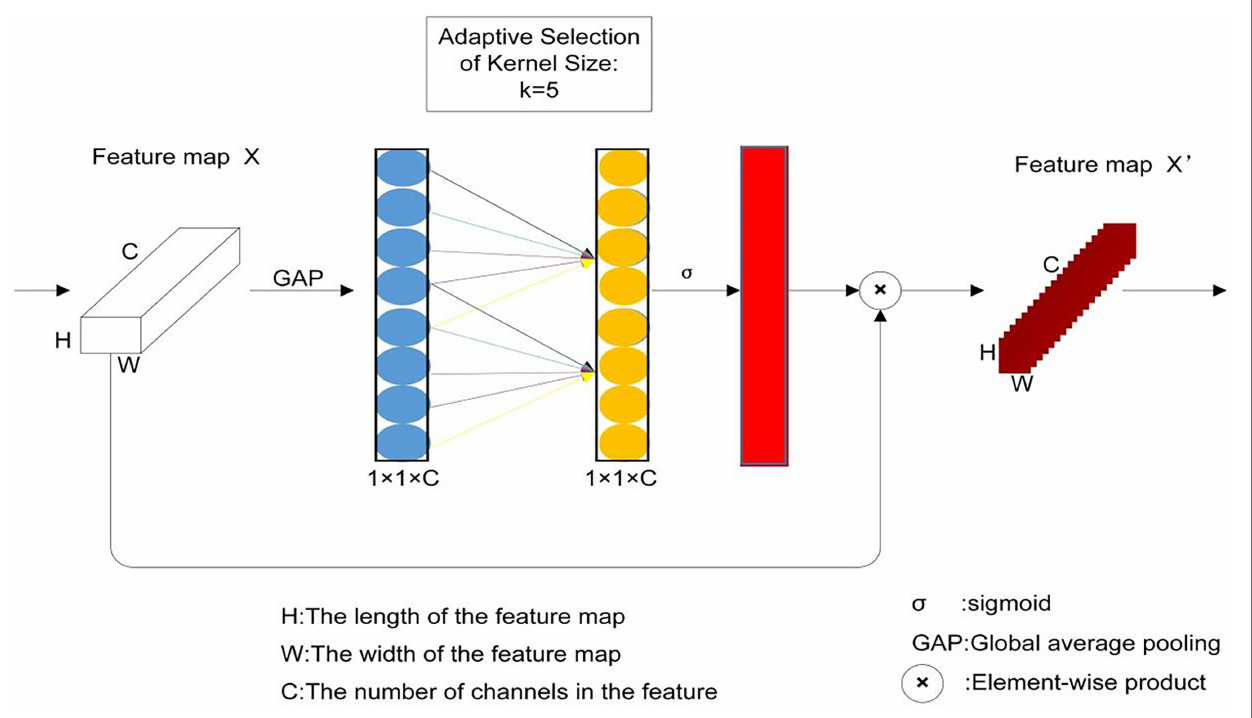
FIGURE 1 | Efficient channel attention